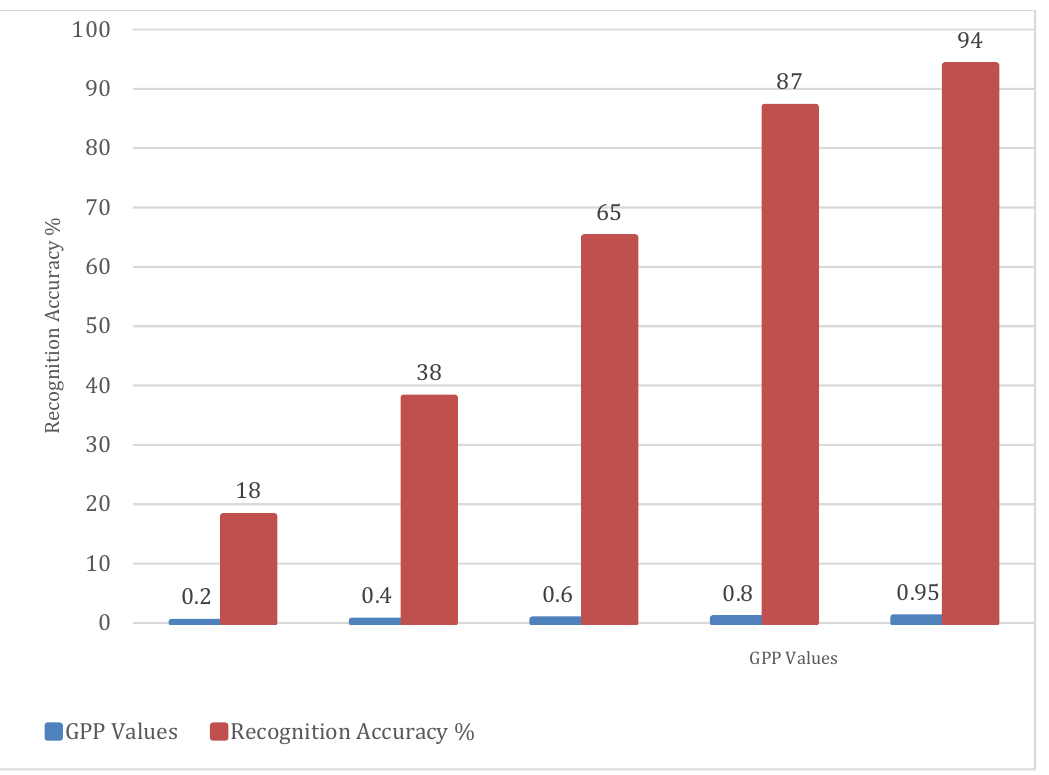
Figure 3. Relationship between recognition accuracy and the GPP values for the phonemes in the Speak Correct system .